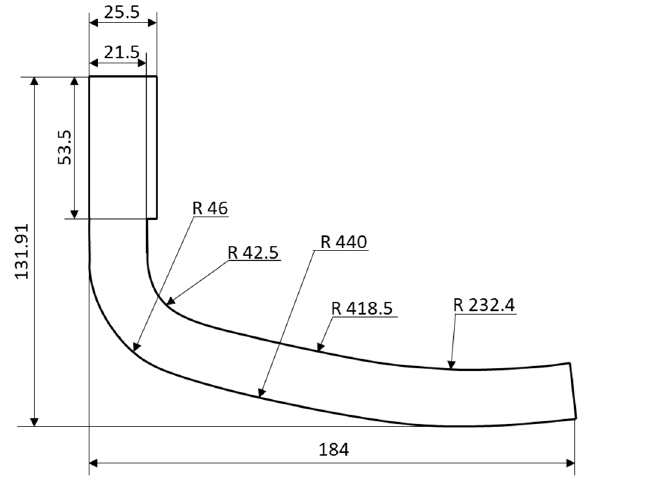
Figure 11. Optimised geometry of the prosthesis component considering a ( a ) T45 and a ( b ) R20 core.